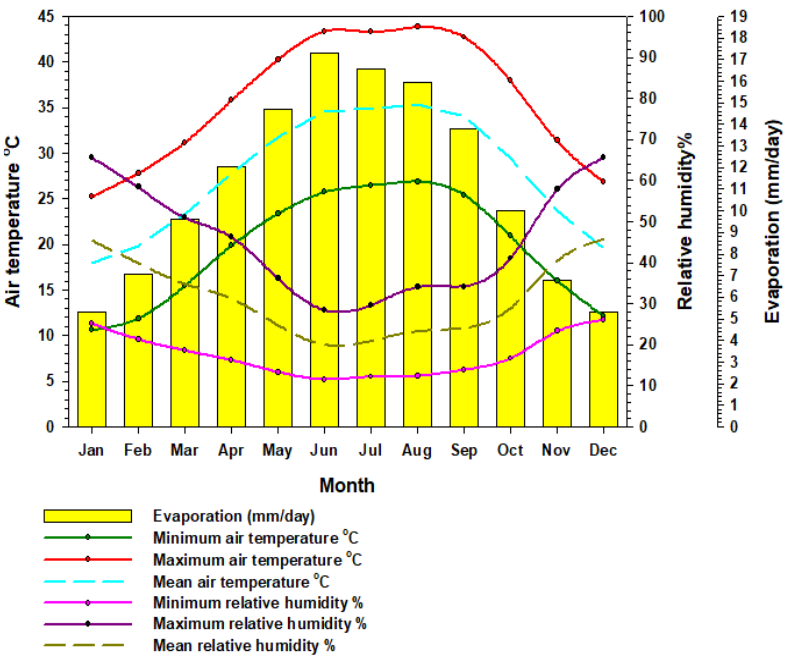
Figure 2. Histogram of annual mean evaporation and curves of annual mean temperature and relative humidity of the study area.